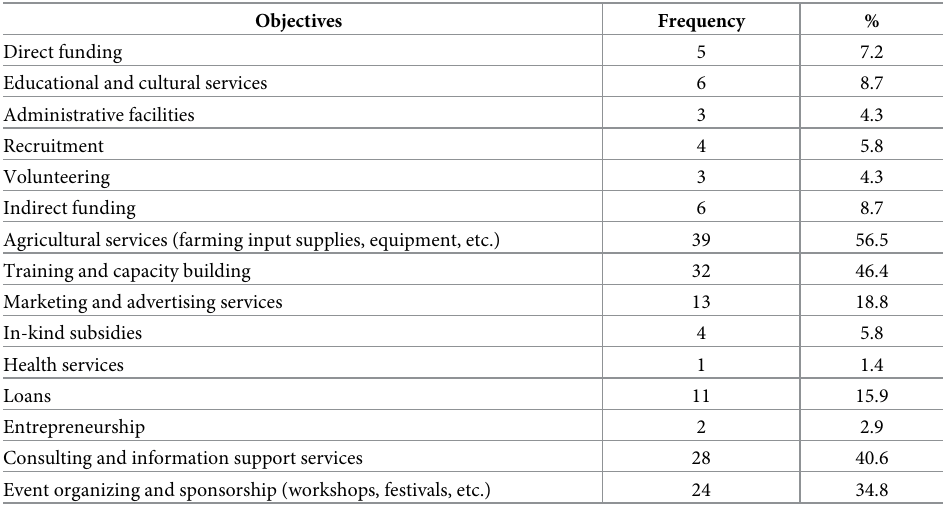
Table 5. Objectives of the partnerships.